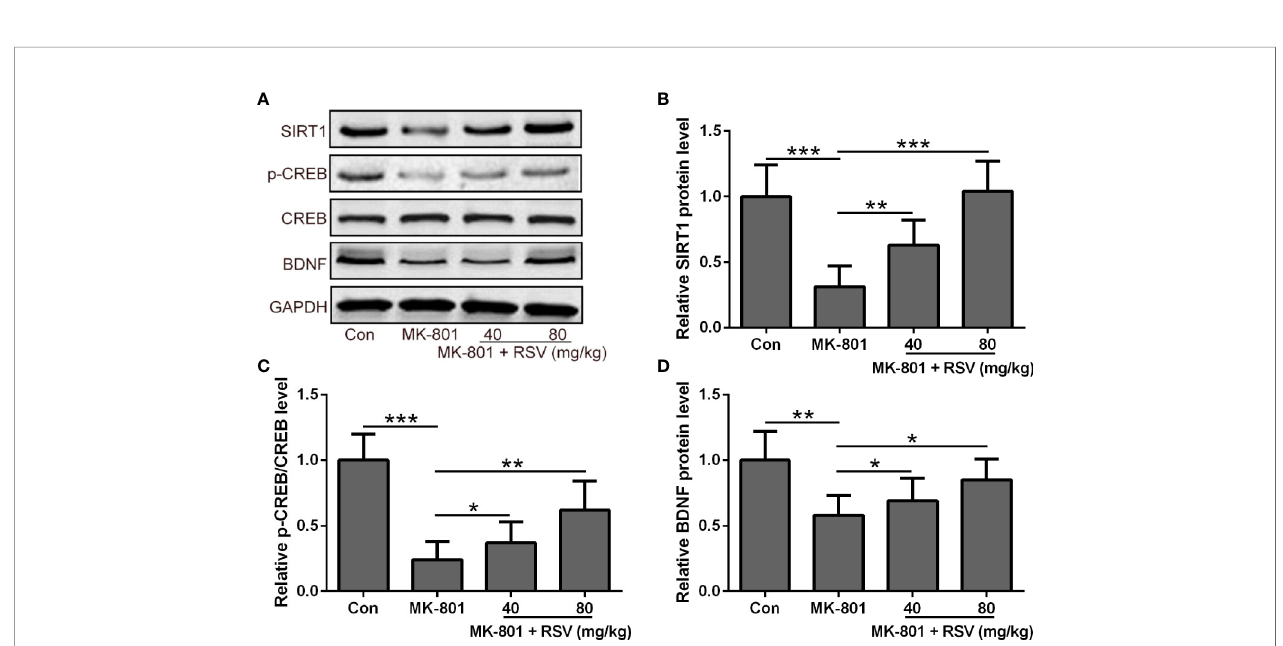
FIGURE 2 | Effect of RSV on the protein expression of SIRT1 and BDNF and CREB phosphorylation in the hippocampus of MK-801 treated rats. (A) Western blot was used to measure the protein expression of SIRT1, p-CREB, CREB, and BDNF in hippocampus. GAPDH was used as loading control. Relative expression was normalized to control group. n = 6 in each group. Data were presented as mean ± SD. F ratios: (B) 21.96 (3.00, 19.71), (C) 26.80 (3.00, 15.08), (D) 8.625 (3.00, 11.37). *p < 0.05, **p < 0.01, and ***p < 0.001 between the indicated groups.